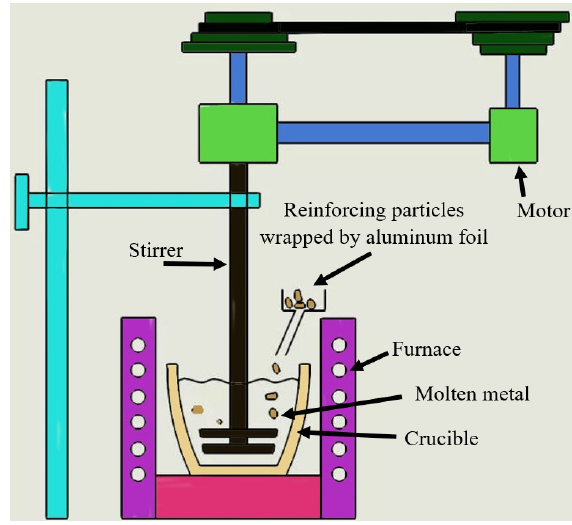
Figure 2. Stir casting